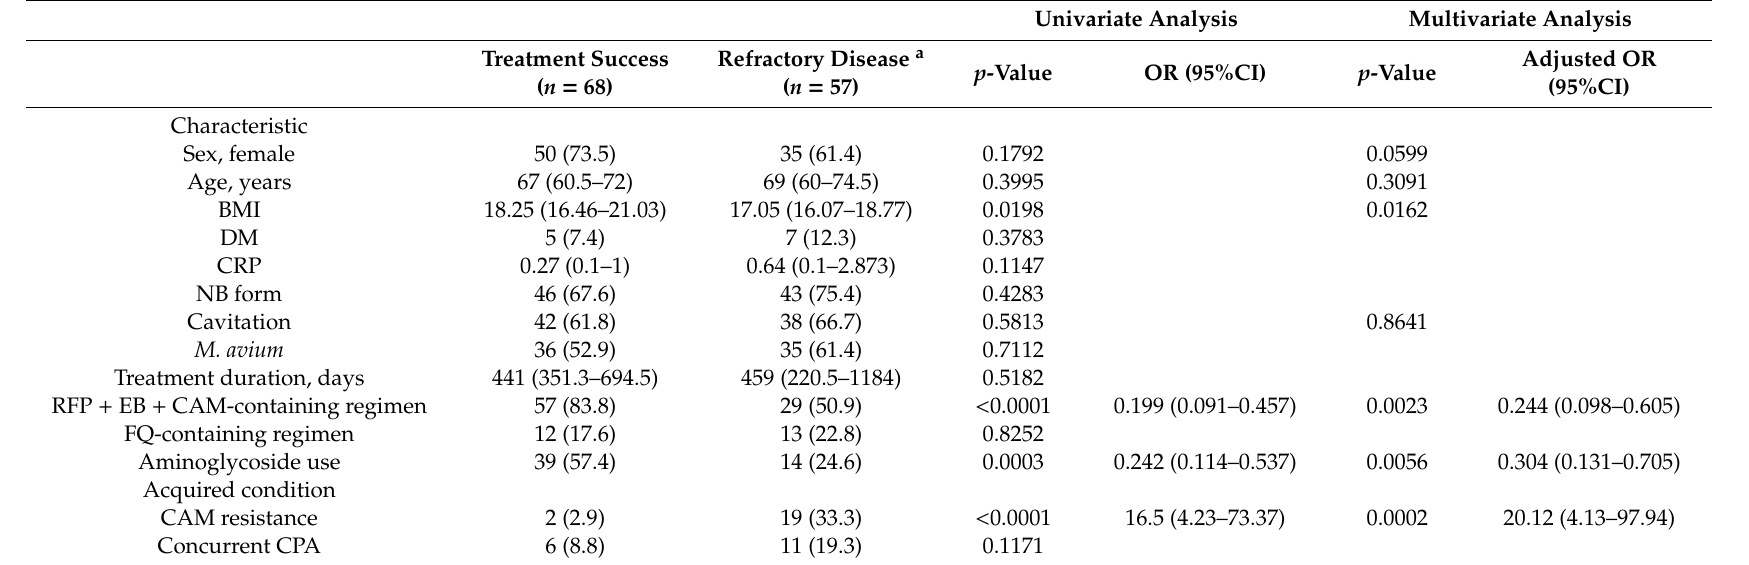
Table 3. Treatment selection modified disease progression and persistence in patients with Mycobacterium avium complex pulmonary disease. Univariate Analysis Multivariate